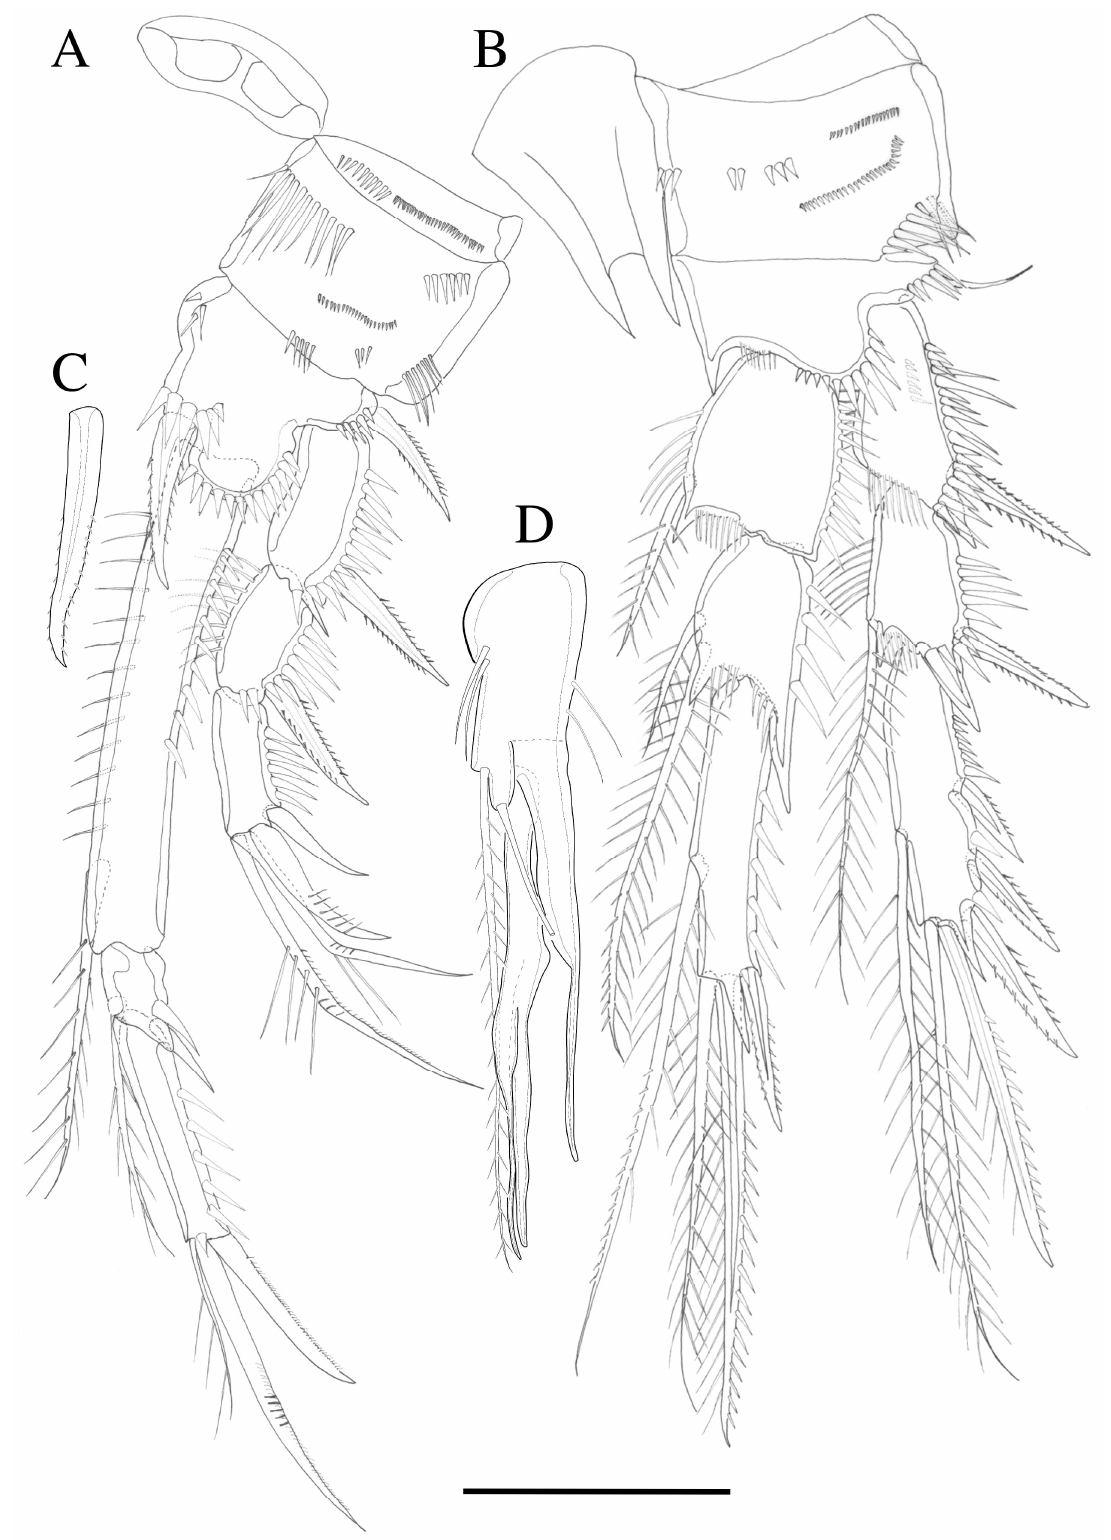
Figure 5. Robertgurneya jejuensis sp. nov. Female. ( A ) P1. ( B ) P2. Male. ( C ) Inner spine of P1 basis. ( D ) P2 enp-2. Scale bar: 50 μm.